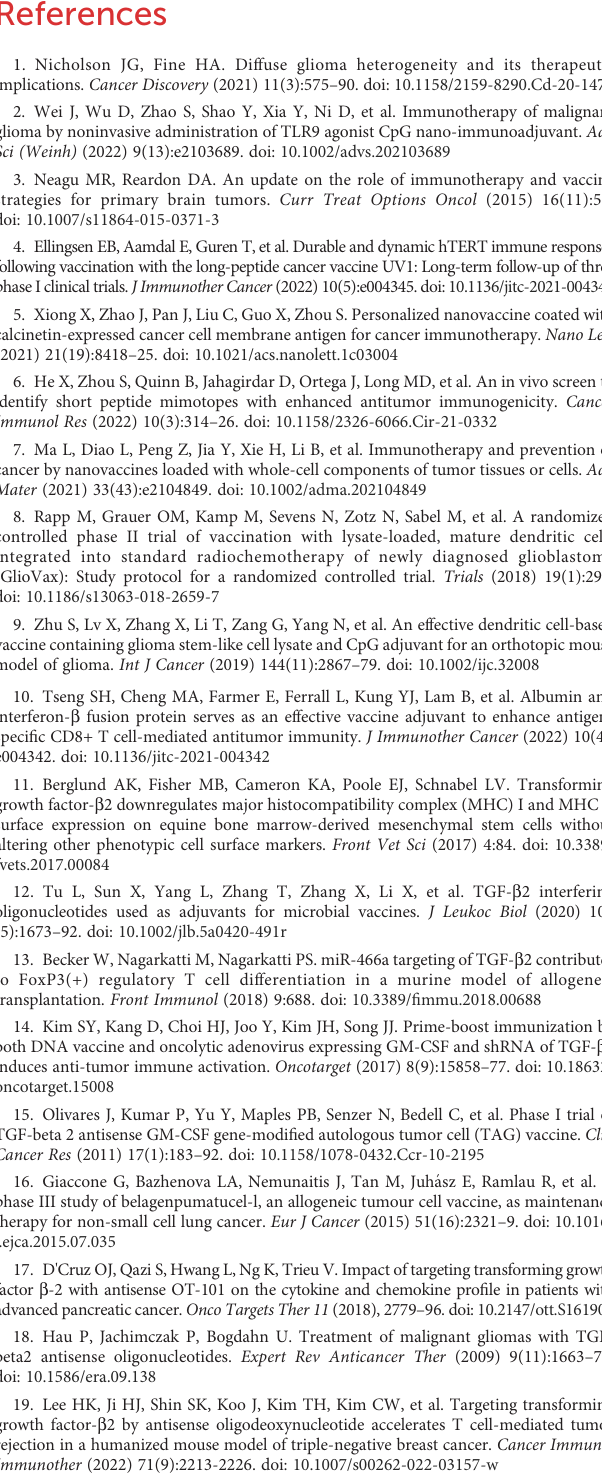
ProtectiveeffectofTIO3asatherapeuticagentonthe insitu